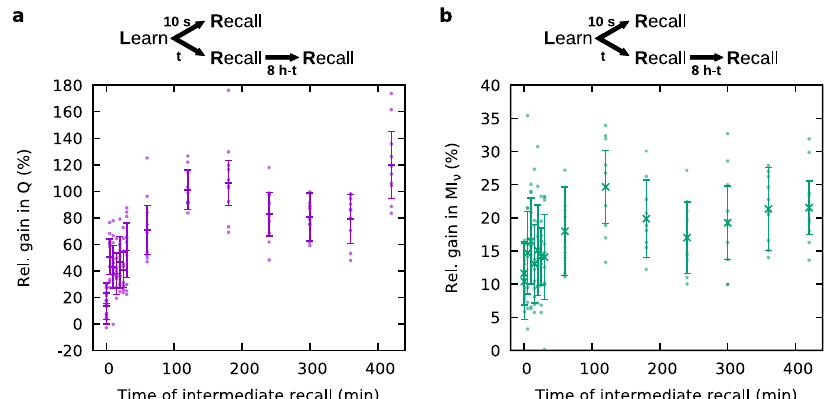
Fig. 9 Relative gain in recall quality between 10 s and 8 h after learning, affected by an intermediate recall stimulus at varying times. a Gain in pattern completion coef fi cient Q ; b gain in mutual information MI ν . Parameter values: w ie / h 0 = 4, w ii / h 0 = 4, n CA = 150. Averaged over ten trials. Error bars indicate the error propagated from the standard deviations across ten trials for both 10s-recall and 8h-recall. The data points at time zero show the case without intermediate recall (as in Fig. 5c,